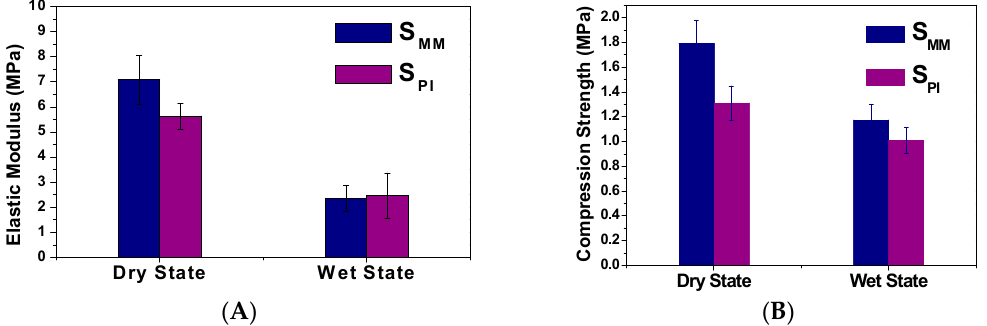
Figure 4. Elastic modulus ( A ) and compression strength ( B ) of S MM and S PI in dry and wet states.